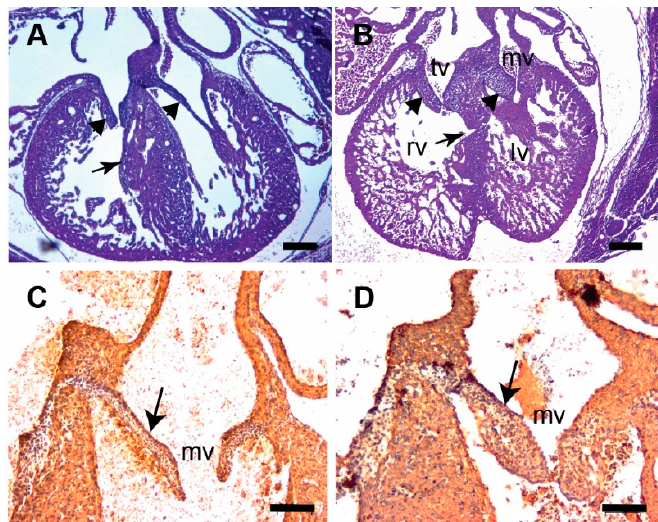
Figure 4. Tgfb3 knockout fetuses exhibit atrioventricular valve thickening. ( A – B ) H&E stained sections of wildtype ( A ) and Tgfb3–/– fetus (E14.5-15.5) showing mitral valve and tricuspid valve thickening ( B , arrowheads). Note that the ventricular myocardium is thin and abnormal with muscular ventricular septal defect in Tgfb3 –/– ( B , arrow). C – D , Cardiac muscle actin (clone HHF35) immunohistochemistry of cross-sections of E15.5-16.5 wildtype ( C ) and Tgfb3 –/– ( D ) fetuses. Tgfb3 –/– fetus develop thickened mitral valves ( D , arrow). Scale bars = 200 μ m for A – B , 50 μ m for C – D . Abbreviations: rv, right ventricle; lv, left ventricle; tv, tricuspid valve; mv, mitral valve.